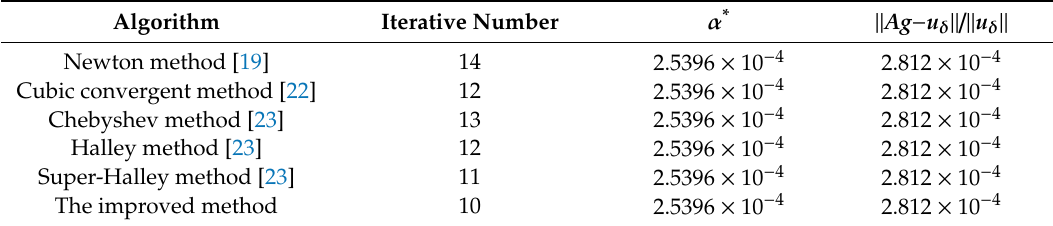
Table 1. The comparison of the improved method with other methods ( α 0 = 0.01, δ = 0.001).